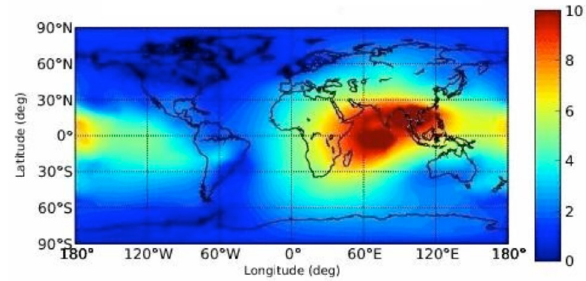
Figure 3. GIM at 05:53 UTC on March 11, 2011.